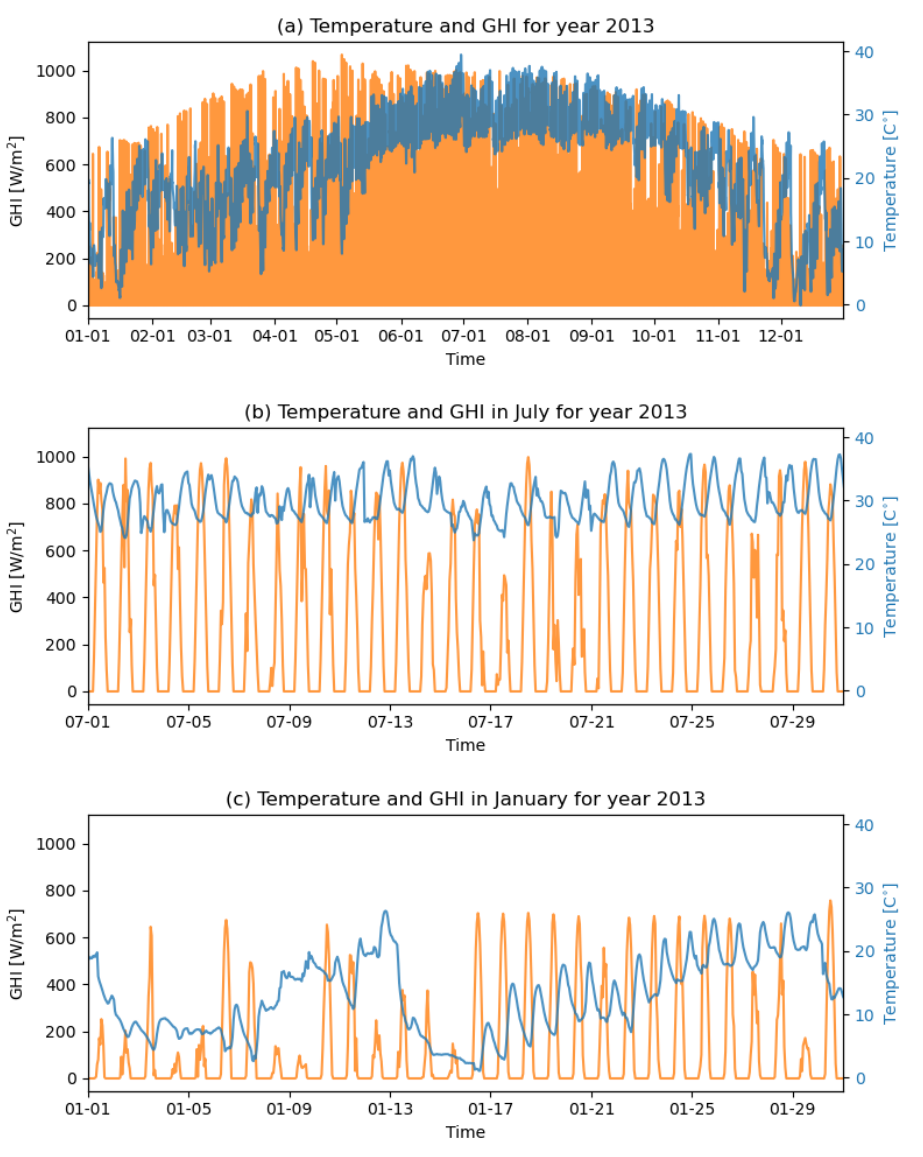
Figure 5. ( a ) Temperature and solar GHI for year 2013 over the whole year. ( b ) Zoom-in views over the summer. ( c ) Zoom-in views over the